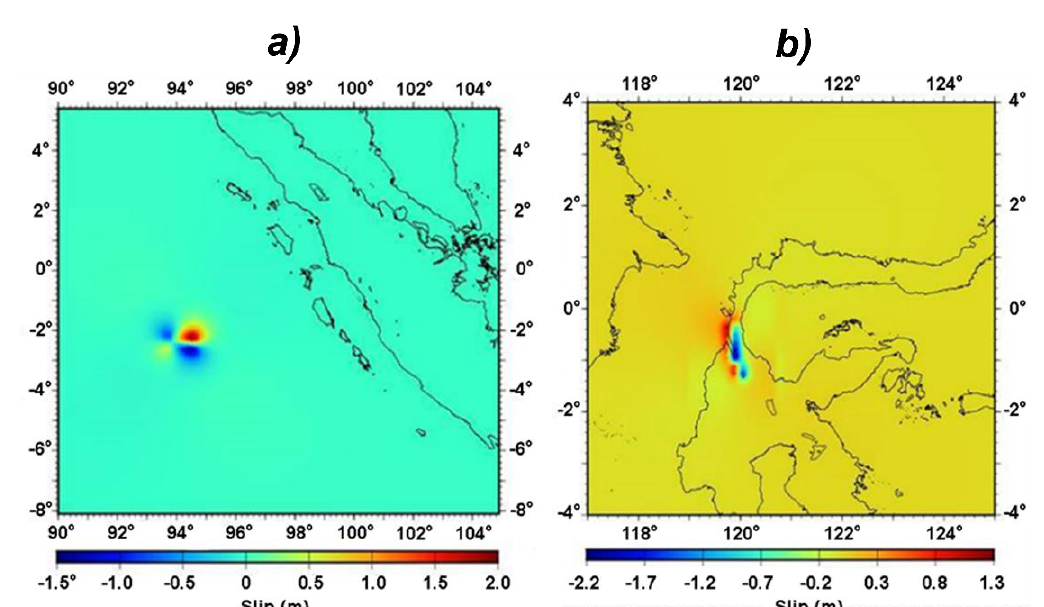
Figure 5. Vertical crustal movements of ( a ) the 2016 West Sumatra earthquake and ( b ) the 2018 Palu earthquake. The earthquakes were calculated using [40], using the fault geometry taken from USGS. Although the earthquakes were dominated by the strike-slip mechanism, significant vertical movements occurred.